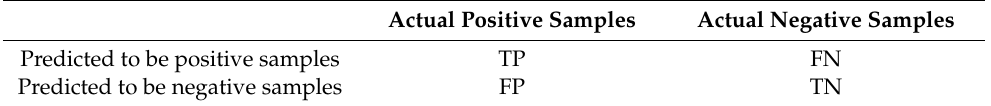
Table 1. Meaning of TP, TN, FP, and FN.